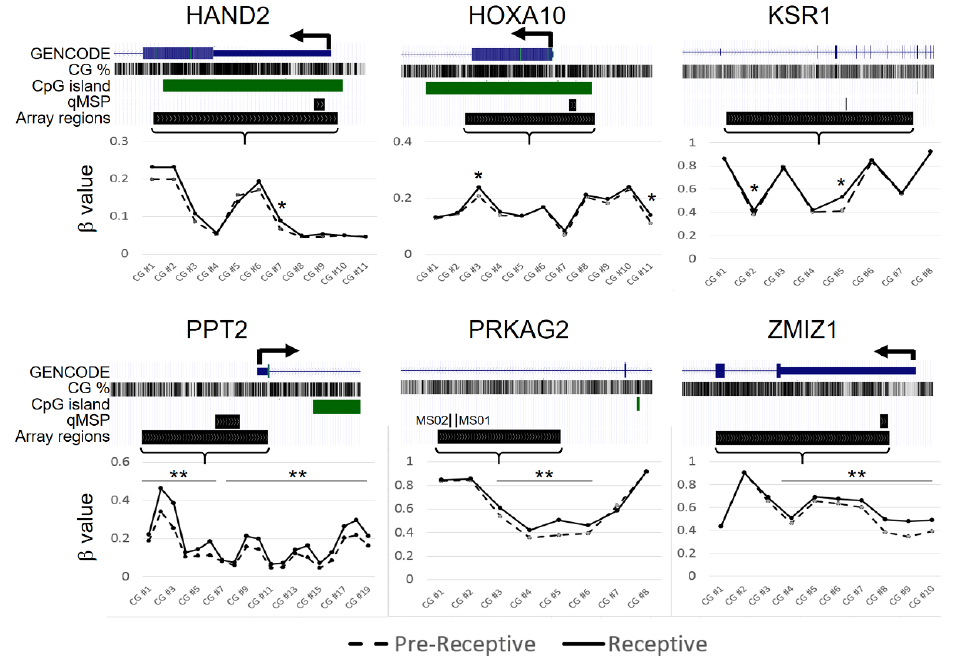
Figure 1. Bioinformatic analysis of six candidate genes (including seven CpG sites); the original genome ‐ wide DNA methylation data originated from NCBI GEO Datasets (GSE90060). The dark ‐ line represents receptive (LH + 7, within implantation window) endometrium, and the dashed line represents pre ‐ receptive (LH + 2, early ‐ secretory) endometrium. The CpG ‐ level methylation analysis showed that the β‐ value was statistically higher in several CpG sites of the six candidate genes in receptive endometrium compared with pre ‐ receptive endometrium. The β‐ values, qMSP amplified regions, and relative genomics features present locations including chr4:173528818 ‐ 173530279 for HAND2, chr7:27173269 ‐ 27174813 for HOXA10, chr17:27552177 ‐ 27604383 for KSR1, chr6:32152427 ‐ 32153135 for PPT2, chr7:151755057 ‐ 151772238 for PRKAG2, and chr10:79310933 ‐ 79315784 for ZMIZ1 according to the hg38 version. qMSP, quantitative methylation ‐ specific PCR; chr, chromosome. * p < 0.05; ** p < 0.01